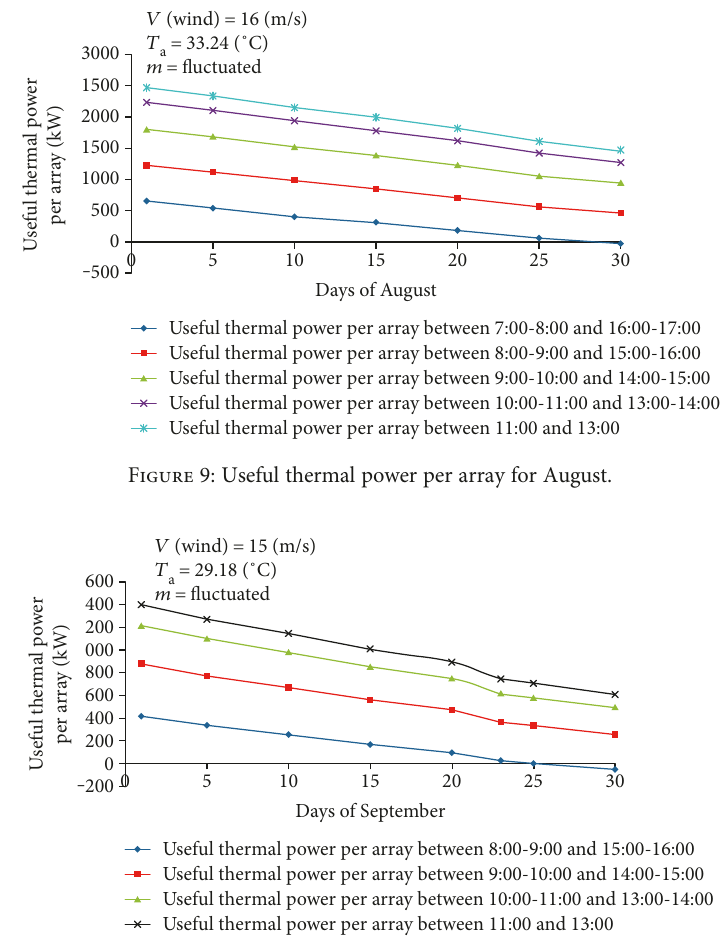
Figure 10: Useful thermal power per array for